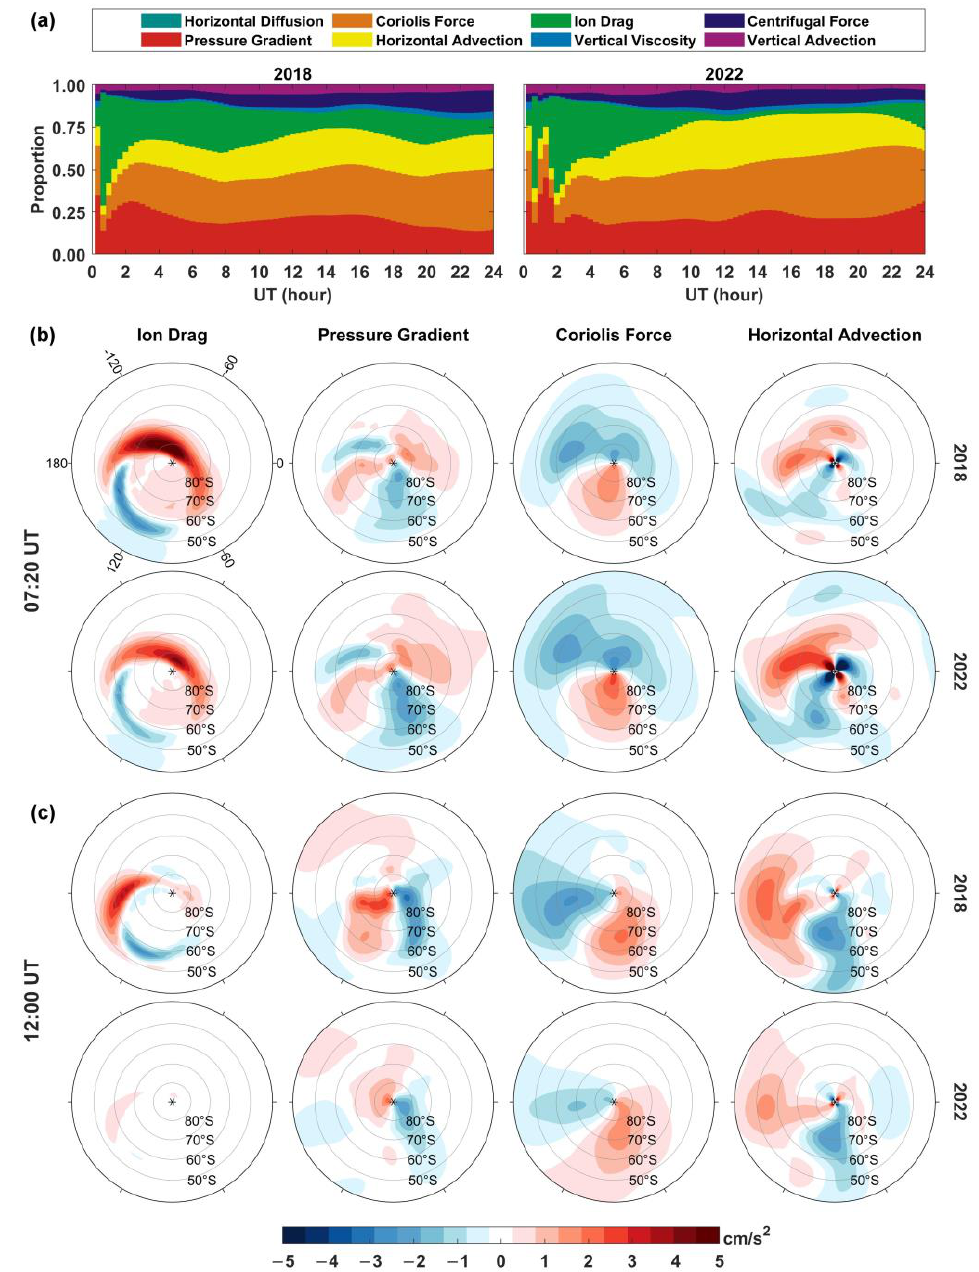
Figure 7. ( a ) The ratios of eight acceleration terms in the zonal wind as shown in Equation (4). ( b ) Mainly zonal acceleration terms: ion drag force (first column), pressure gradient force (second row), Coriolis force (third row), and horizontal advection (fourth row) for the 2018 event (first row) and 2022 event (second row) around 130 km on the first day of the storm (April 20 for the 2018 event and April 10 for the 2022 event) at 07:20 UT. ( c ) Same as ( b ), but corresponding to 12:00 UT. The black asterisks mark the locations of the South Pole.